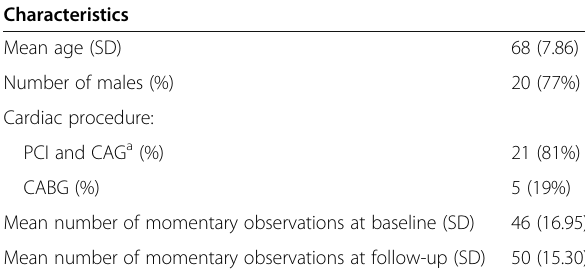
Table 1 Patient characteristics at baseline ( N = 26)